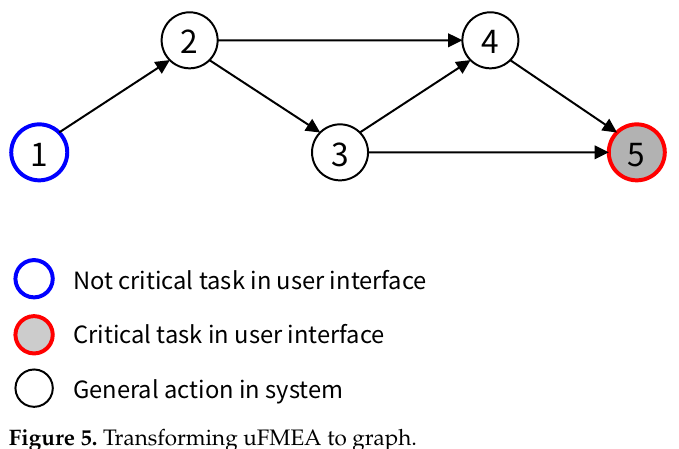
Figure 5. Transforming uFMEA to